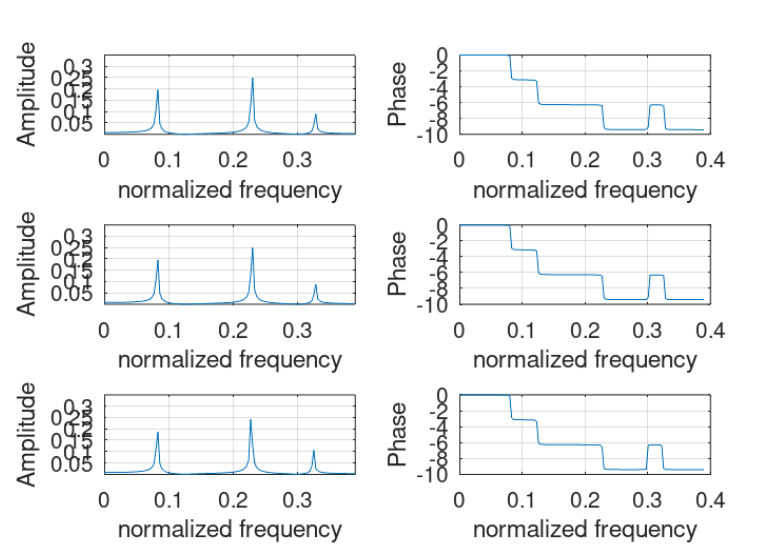
Figure 6. Comparison of original (upper) and transformed frequency responses with θ = e pT , + pT ζ = 2 , and T = 0.0033. 2 − pT